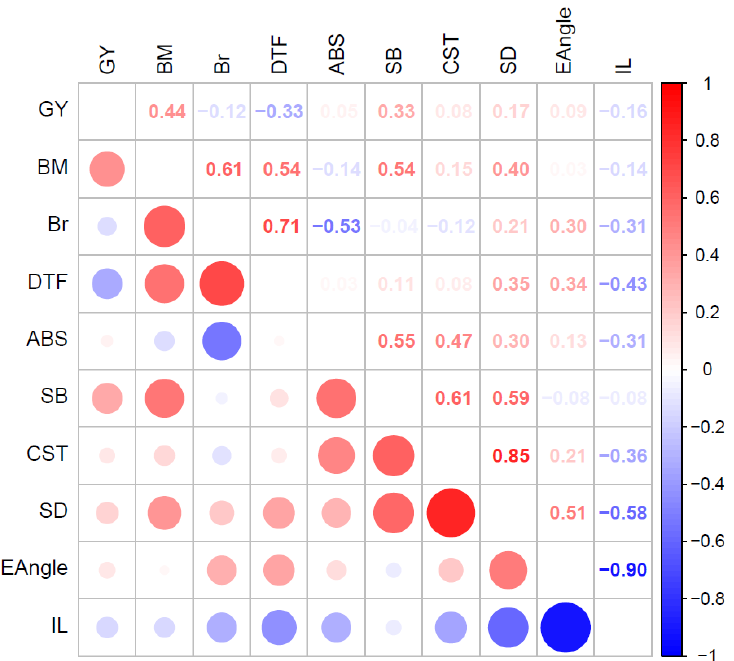
Figure 3. Additive genetic correlations calculated from the additive variance and covariance components from the optimized multivariate linear mixed model of 10 traits: single plant grain yield (GY), dry biomass (BM), basal branches (Br; square root transformed), days to flower (DTF), ascochyta blight score (ABS), stem buckling (SB), compressed stem thickness (CST), stem diameter (SD), early stem angle (EAngle), and internode length (IL). Actual values of the genetic correlations are shown above the